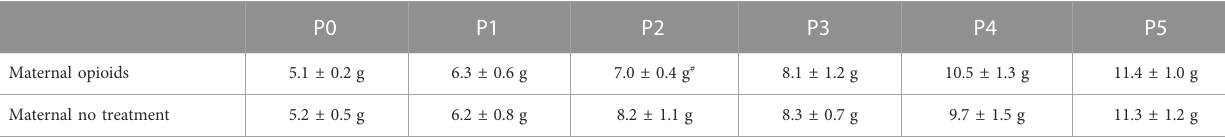
TABLE 1 Maternal opioids delayed neonatal weight gain at P2, but not at other